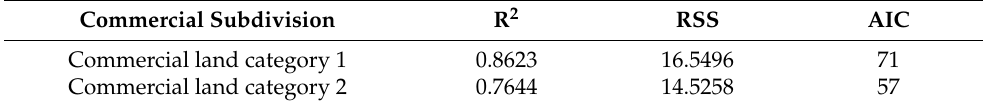
Table 11. GTWR goodness of fit statistics of different commercial land types.